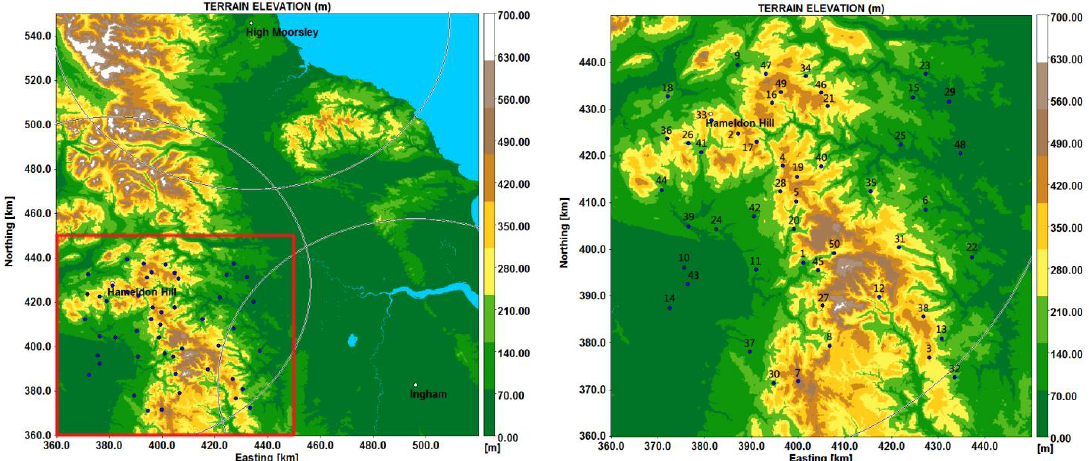
Figure 1. Map of the rain gauge network with the terrain elevation in the background. The blue dots represent the rain gauge locations and the white dots represent the approximate locations of the weather radars. The numbers represent the index of the corresponding gauges. Table 1. Details of four illustrative storm events.